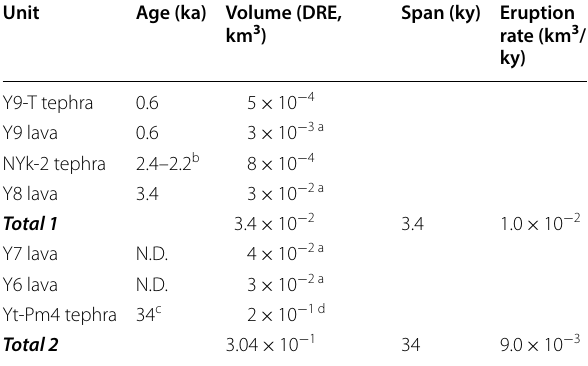
Table 5 Age and volume of eruptive products and estimated eruption rate of Yokodake during the last 34 ky and 3.4 ky